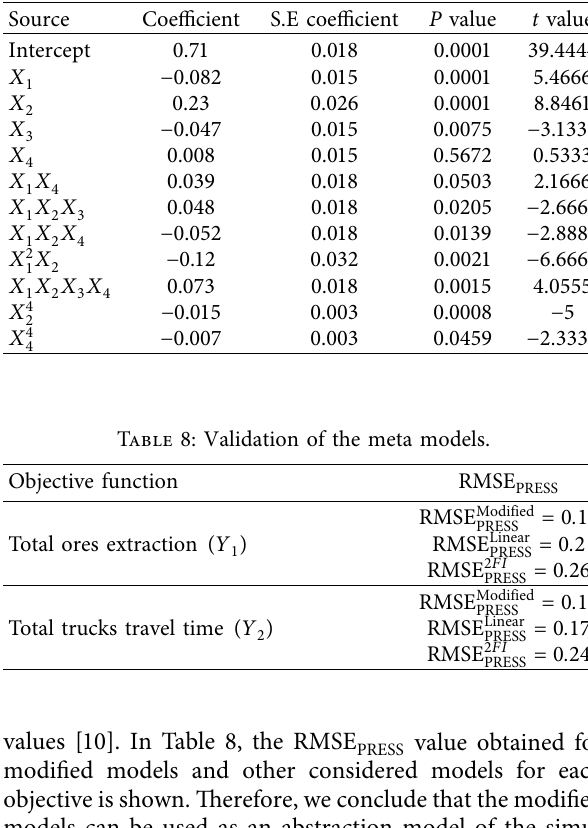
Table 7: Estimated effects and coefficients for the haulage transport